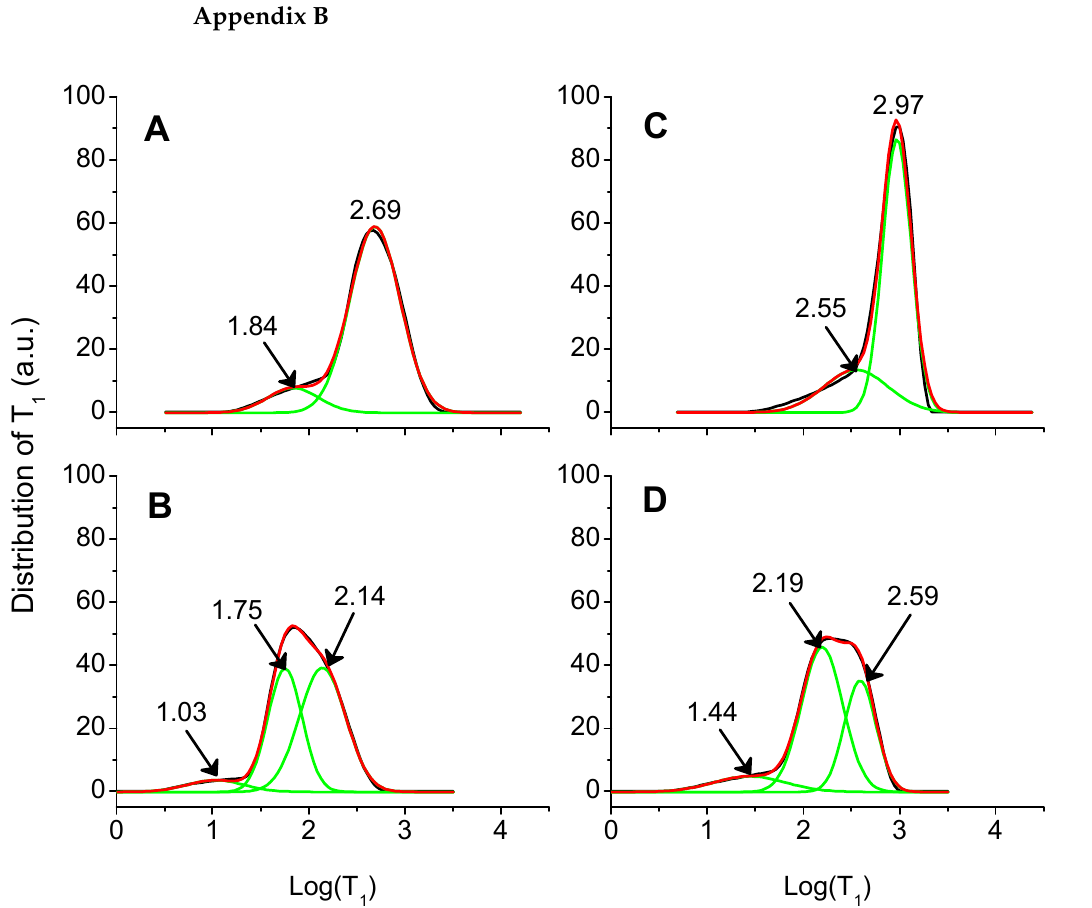
Figure A2. Examples of relaxograms for the data acquired at 10 MHz. ( A ) reports the relaxogram for BCDB; ( B ) reports the relaxogram for BCDA; ( C ) reports the relaxogram for BCWB; ( D ) reports the relaxogram for BCWA. The black curves were obtained by the UPEN algorithm. The green curves (used to obtain the PCI values reported in the main text) were obtained by deconvolution of the black ones. The red curves are the linear combination of the green curves. They show how good the deconvolution was. Indeed, the red curves are superimposed, with a good approximation, to the black ones.